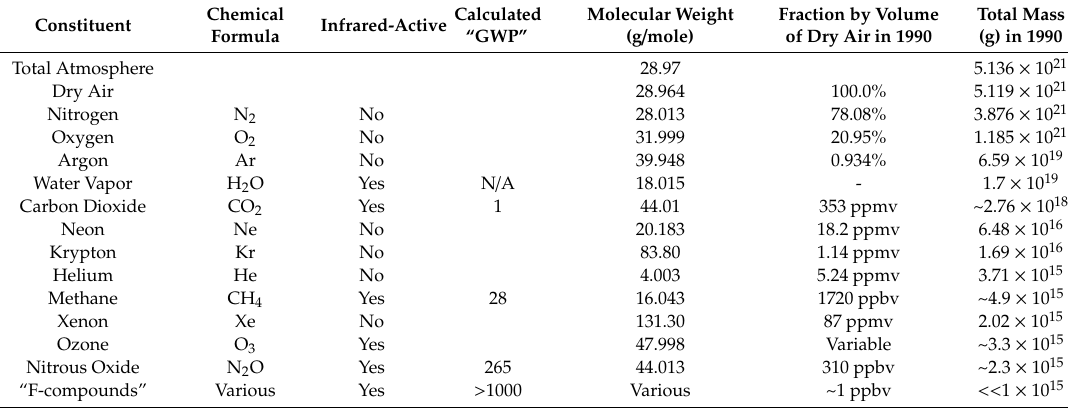
Table 1. Key statistics on the Earth’s atmospheric composition. The fraction by volume and total mass figures are adapted from Table 1 of Hartmann (1994) [32]. Calculated “Global Warming Potential (GWP)” values are taken from Table 8.7 of the Intergovernmental Panel on Climate Change (IPCC) Working Group 1’s 5th Assessment Report (2013 [33]). One ppmv is one part per million (by volume), i.e., 0.0001% and one ppbv is one part per billion (by volume), i.e.,